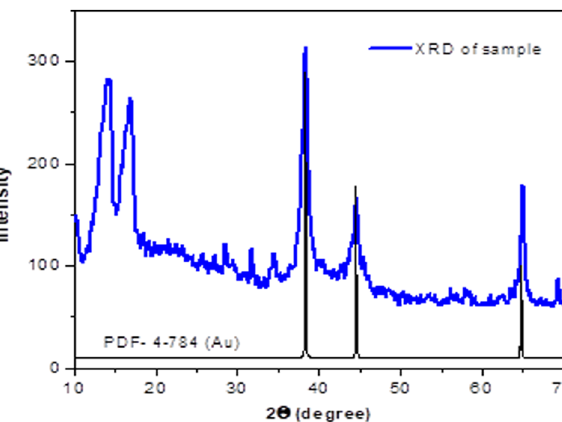
Figure 6: X - ray di ff ractogram of SE - AuNPs. The standard di ff raction pattern of Au ( JCPDS PDF no. 4 - 784 ) is also shown at the bottom.